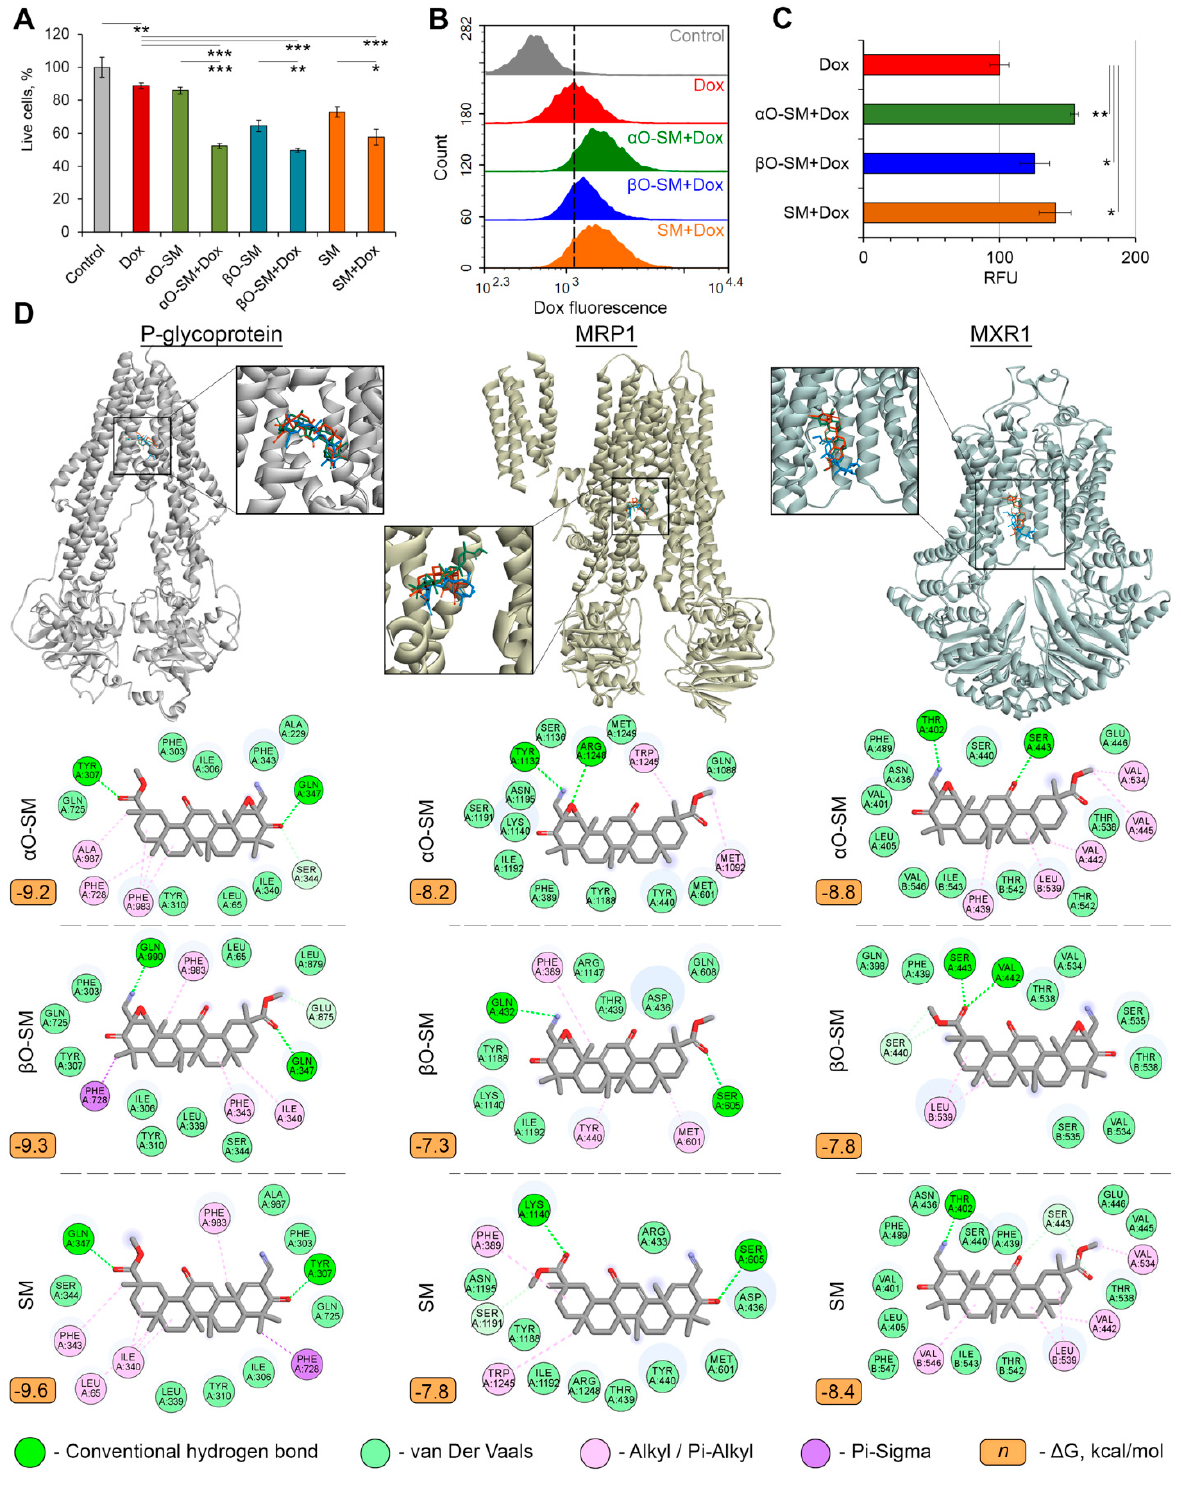
Figure 2. The effects of SM epoxides on doxorubicin uptake by B16 melanoma cells. ( A ) The effect of α O-SM , β O-SM or SM on doxorubicin cytotoxicity induced in B16 cells. B16 cells were incubated with SM (0.5 µM) or α O-SM / β O-SM (1 µM) either in the presence or in the absence of doxorubicin (1 µM) for 72 h followed by the assessment of cell viability by MTT assay. Control–untreated cells. The data are represented as the mean ± SD of three independent experiments. ( B ) Doxorubicin (1 µM) fluorescence intensity in B16 cells exposed to SM (0.5 µM) or α O-SM / β O-SM (1 µM) and doxorubicin for 3 h. ( C ) Relative fluorescence intensity of B16 cells incubated with doxorubicin, SM and SM-epoxides. The data are expressed as mean ± SD of three independent ex-